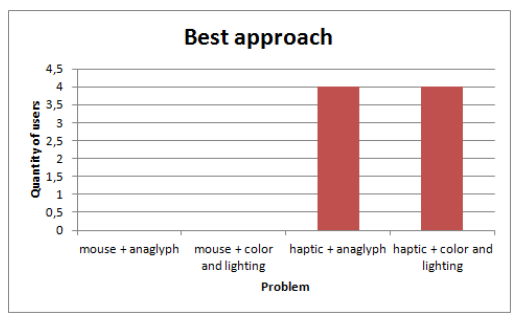
Figure 28. ViMeTGame evaluation question about the best approach used in the